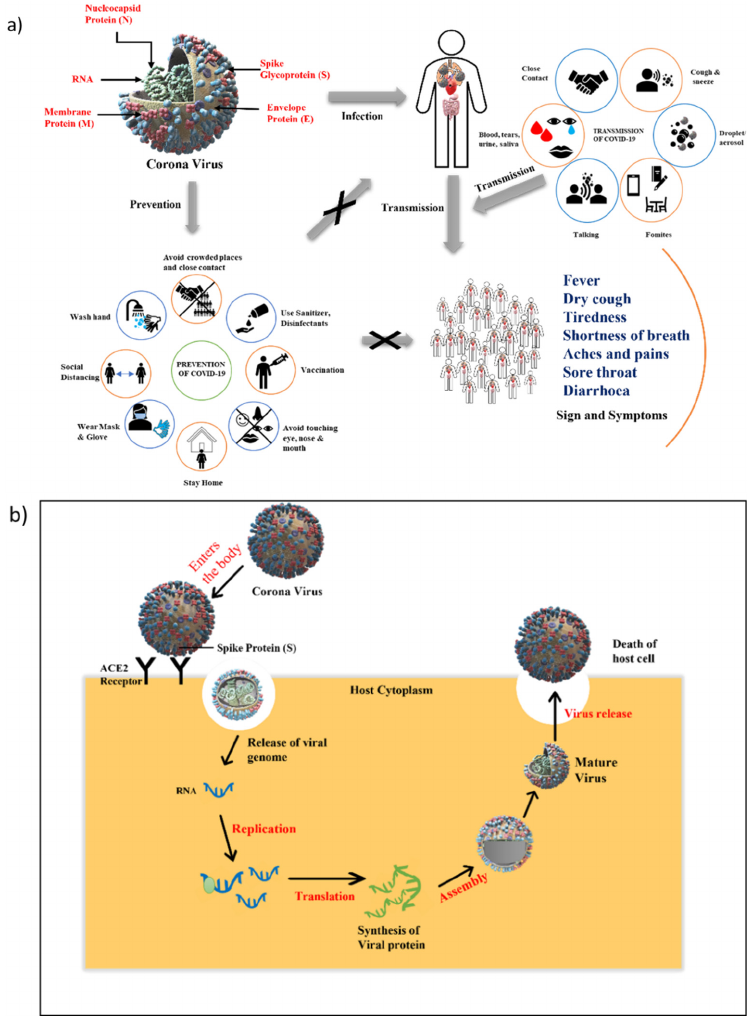
Figure 1. Schematic overview of COVID-19 transmission and lifecycle: ( a ) Prevention, transmission, signs and symptoms, and ( b ) lifecycle of coronavirus (Inspired from Liu et al. [18]).